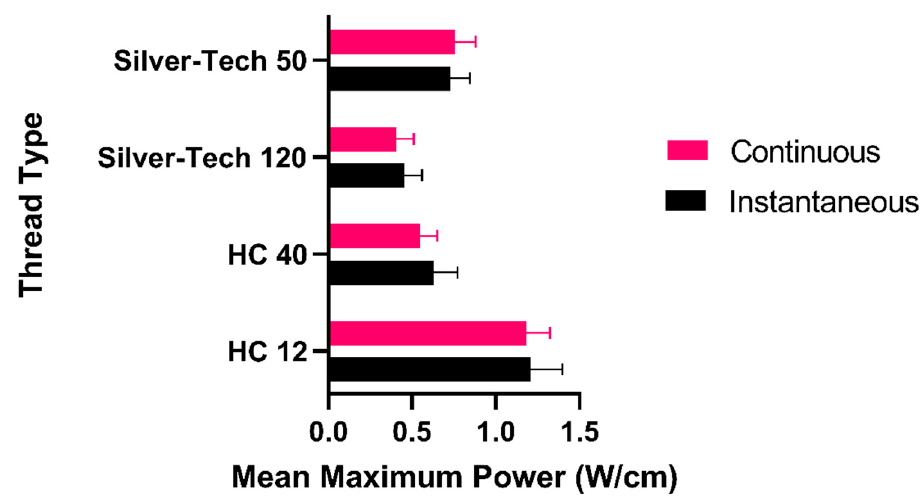
Figure 5. Mean maximum power attained per thread and testing mode.